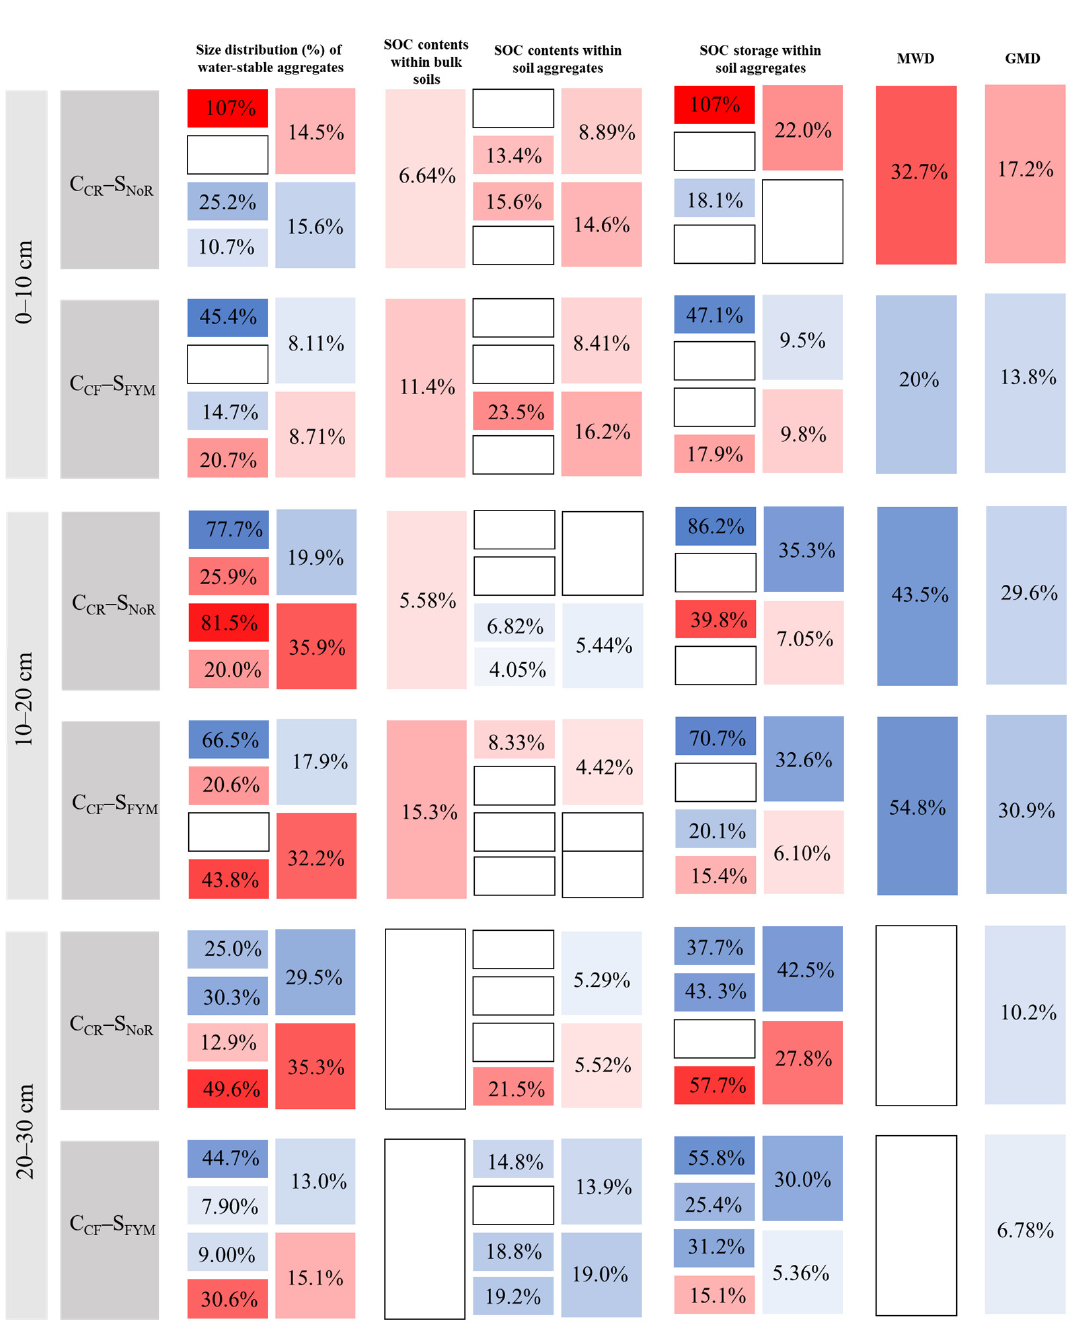
Figure 3. Summarized diagram of the relationship between most important indicators and soil aggregate stability under organic amendments. Note: Changes in indicators was C CR –S NoR and C CF –S FYM treatments compared with C CF –S CF treatment. Red and blue blocks represent increment and decrement, respectively, and the shade color represents the change amplitude. The four blocks in a vertical row from top to bottom represent >2 mm, 2–0.25 mm, 0.25–0.053 mm, and <0.053 mm sized aggregates. The two blocks in a vertical row from top to bottom represent macroaggregates (>0.25 mm) and microaggregates (<0.25 mm). Table 5. SOC storage (t hm − 2 ) within soil aggregates.